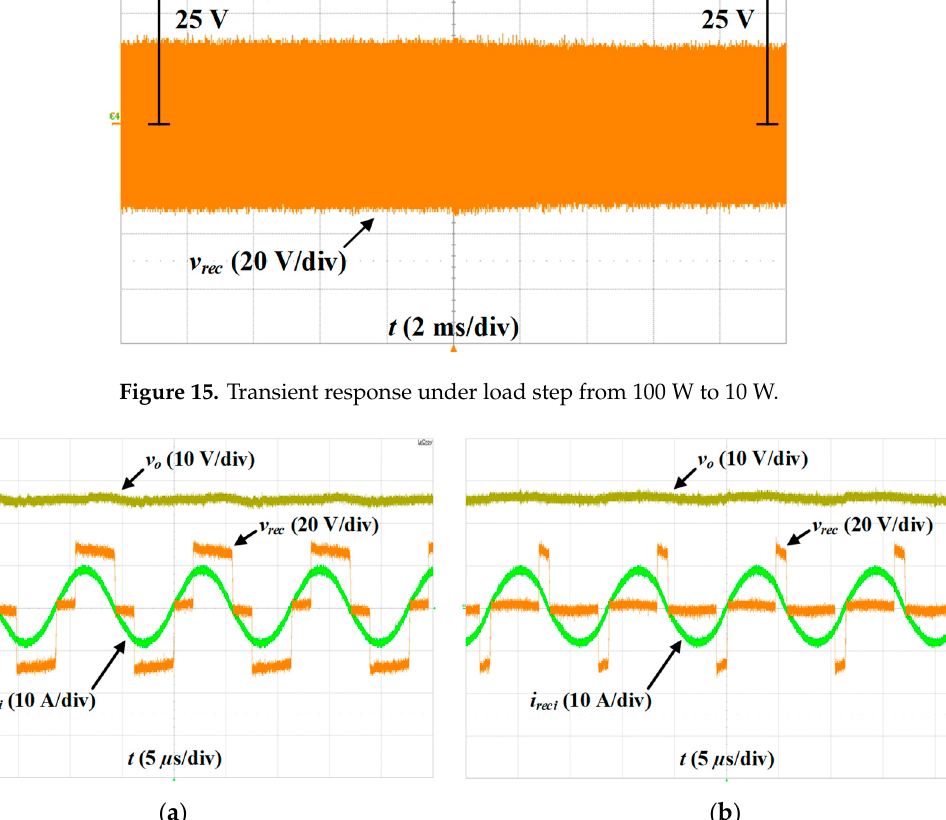
Figure 16. Experimental waveforms when voltage reference is 25 V: (a) P o = 100 W; (b) P o = 10 W.